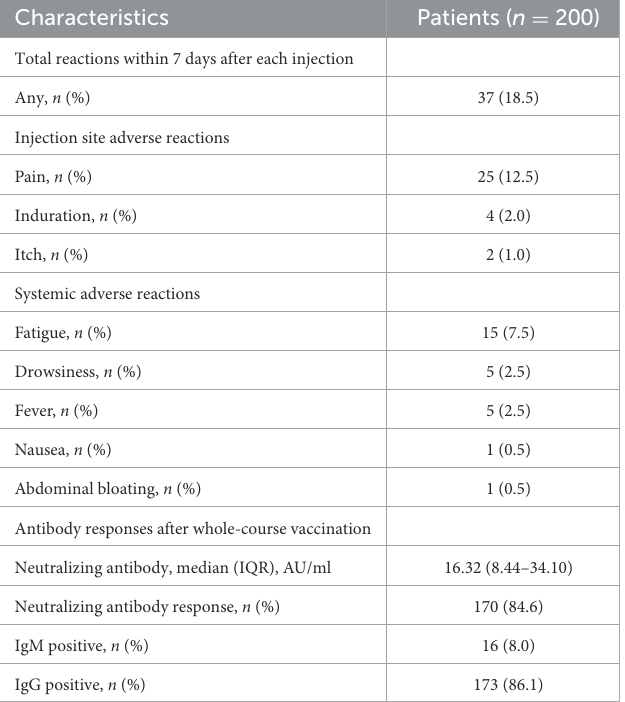
TABLE 2 Safety and immunogenicity of COVID-19 vaccination in patient with CHB.